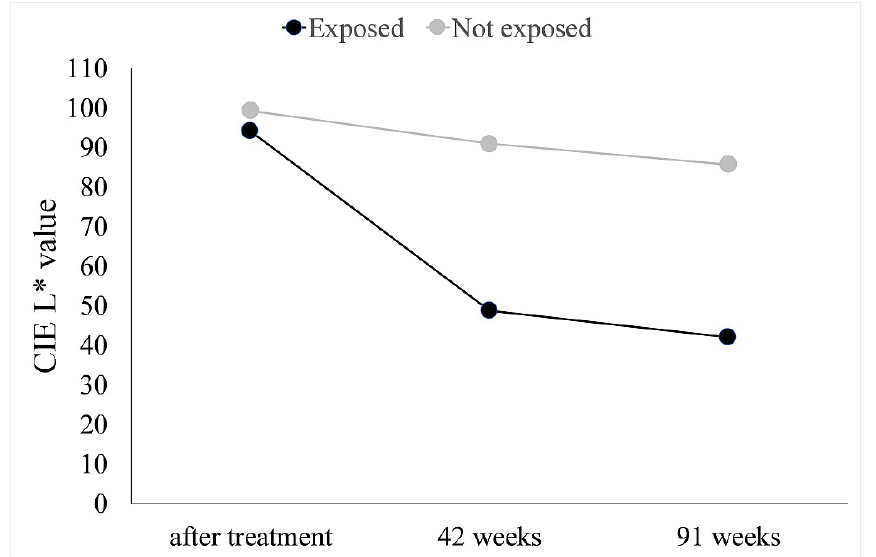
Figure 4. Mean L‐values of spruce specimens of sample set 2 ( n = 3) treated with iron (II) sulfate before and after 42 and 91 weeks of exposure to sun light. Three of the specimens were exposed to sunlight, 3 of them were kept in darkness (Figure 5, Table 3).